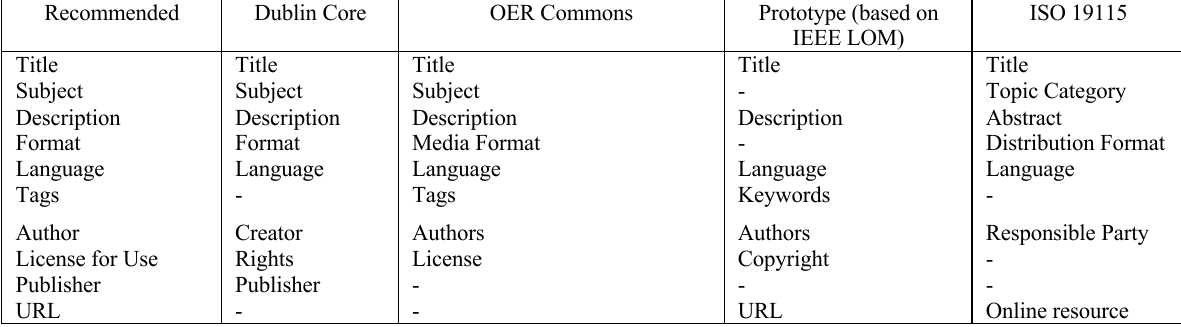
Table 1. Recommended metadata attributes used by all participants in the same way